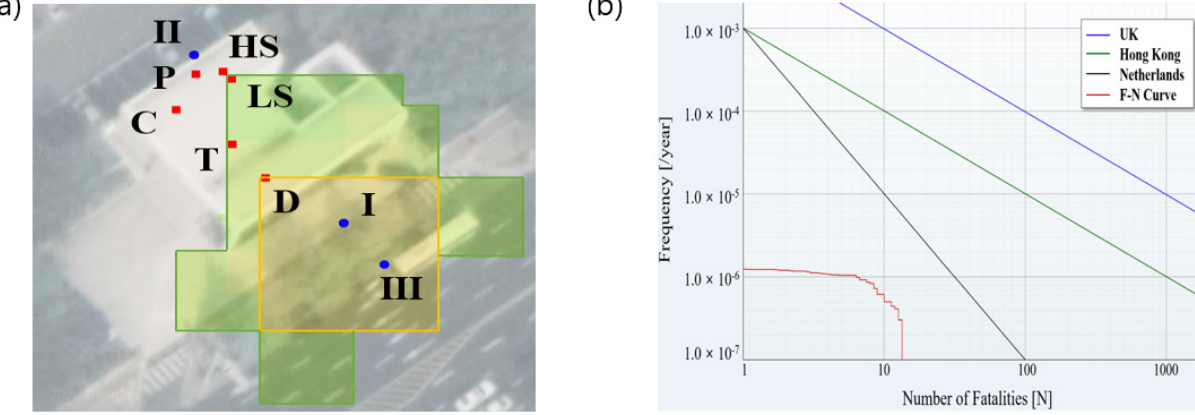
Figure 7. Analysis of societal risk according to applied to active IPLs. ( a ) analysis of the contribution of societal risk posed by hydrogen refueling facilities and ( b ) F–N curve analysis according to the application of active IPLs.